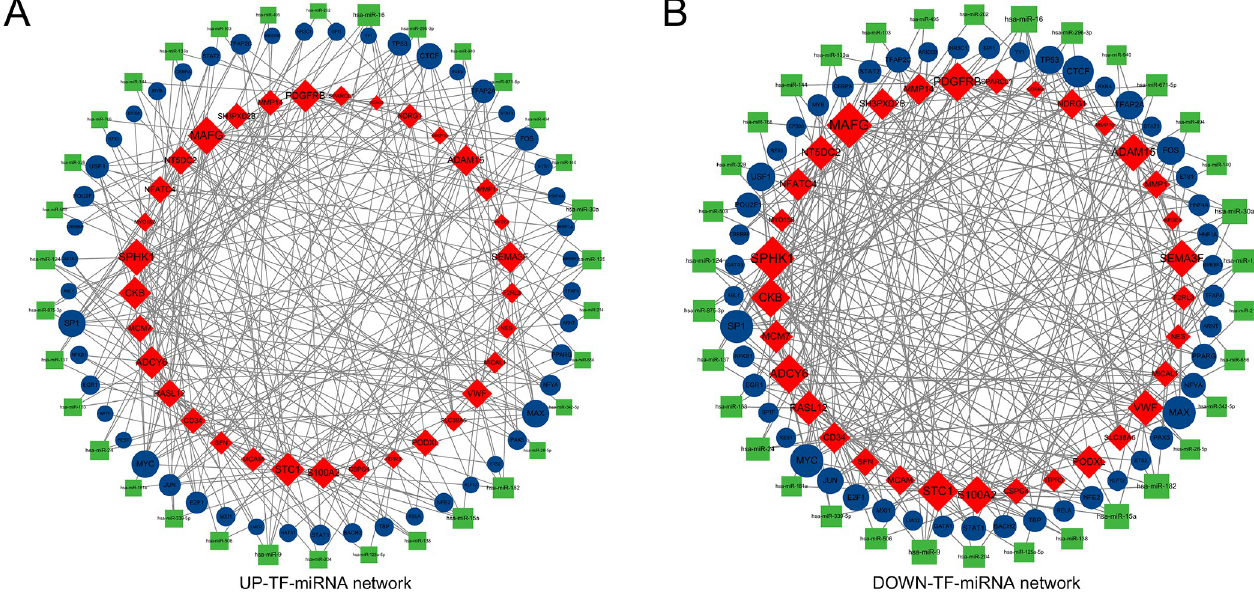
Fig 8. The network presents a TF-miRNA co-regulatory network. Red, orange and yellow nodes are differentially expressed genes, green nodes indicate miRNAs and blue nodes indicate TF-genes.